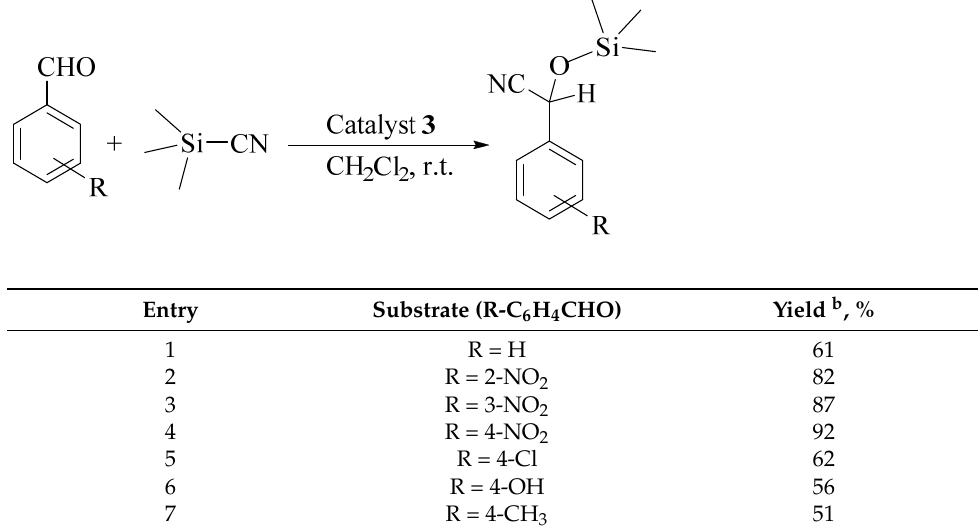
Table 2. Substrate scope in cyanosilylation of various benzaldehydes with TMSCN catalyzed by 3 . a